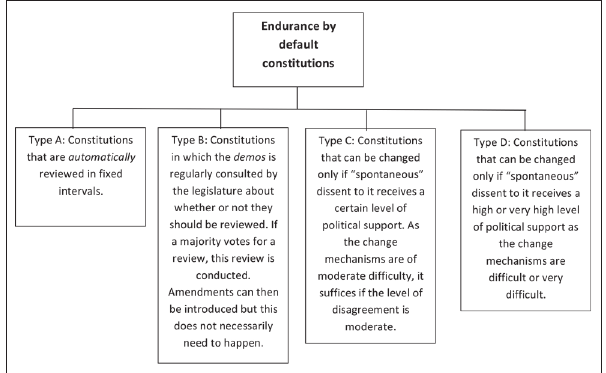
Figure 1: Different forms of endurance by default